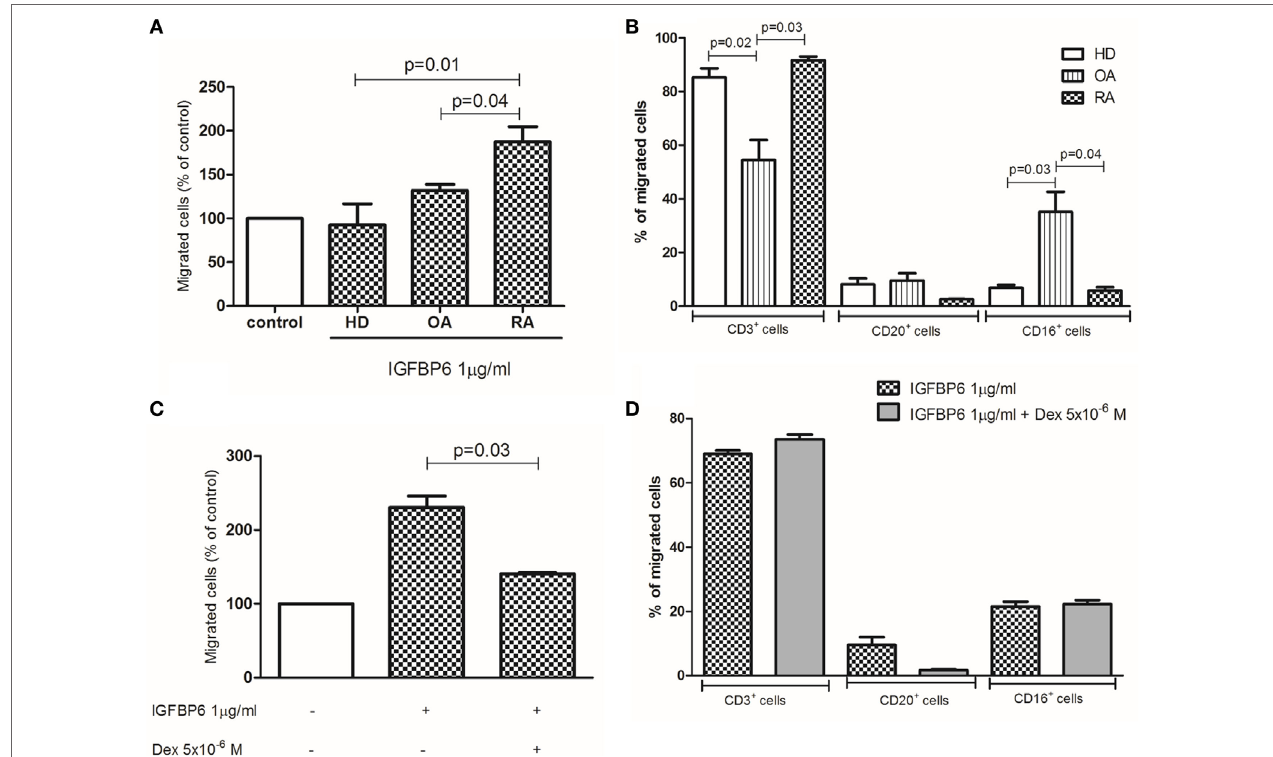
FigUre 6 | In vitro migration assay . Insulin-like growth factor binding protein 6 (IGFBP6) is able to induce the migration of rheumatoid arthritis (RA) but not healthy donors (HD) and osteoarthritis (OA) peripheral blood mononuclear cells (a) . The addition of dexamethasone (dex) in the upper chamber of the transwell partly inhibited such RA cell migration (B) . The majority of RA-migrated cells are CD3 + T lymphocytes (c) and the addition of dex does not affect the proportion of migrated cells (D) . All p values are calculated with Mann–Whitney U